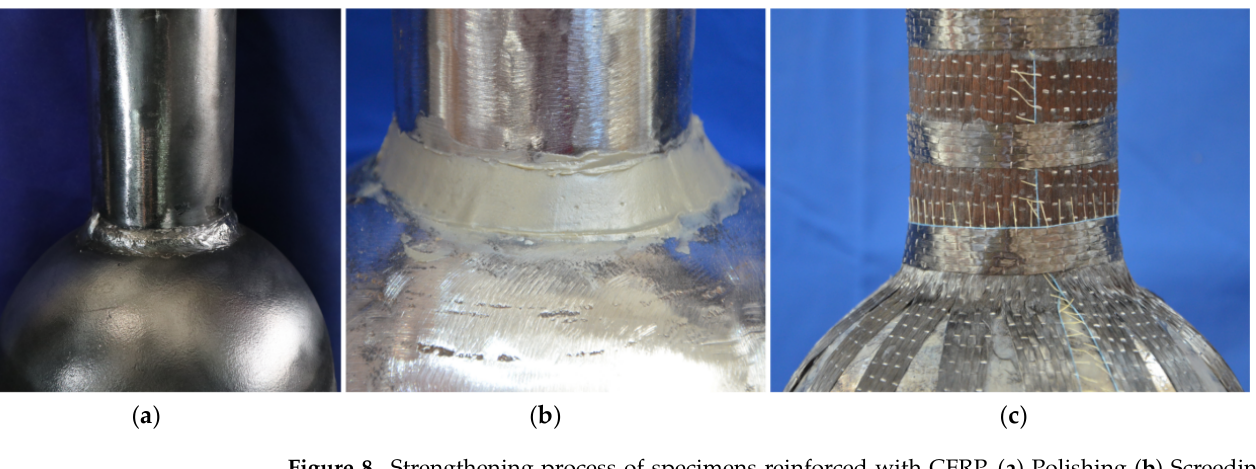
Figure 8. Strengthening process of specimens reinforced with CFRP. ( a ) Polishing ( b ) Screeding ( c ) Pasting.